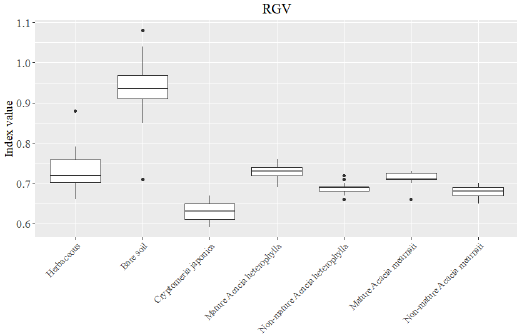
Figure 6. Values of the best spectral index (RGV) as selected by the RFE algorithm for different land cover types, Western Highland Region, Reunion